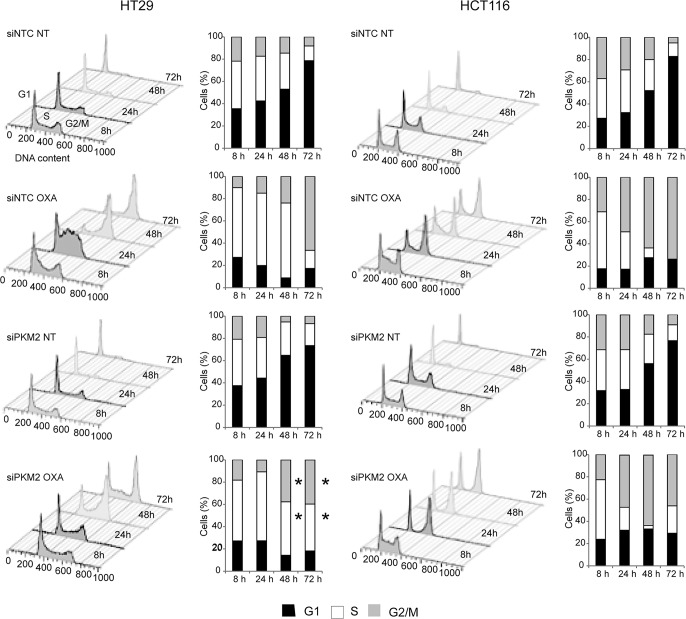
Cell cycle distribution in HT29 and HCT116 cells after PKM2 gene silencing and treatment with OXA.Both cell lines were transfected and/or exposed to 10 μM OXA for 8, 24, 48 and 72 h. After propidium iodide staining, the proportion of cells in cell cycle phases G1, S and G2/M was measured by flow cytometry and quantified by Flowjo v9.2 software. Results are representative of at least three independent experiments. P-values ≤ 0.05 are represented as a *.